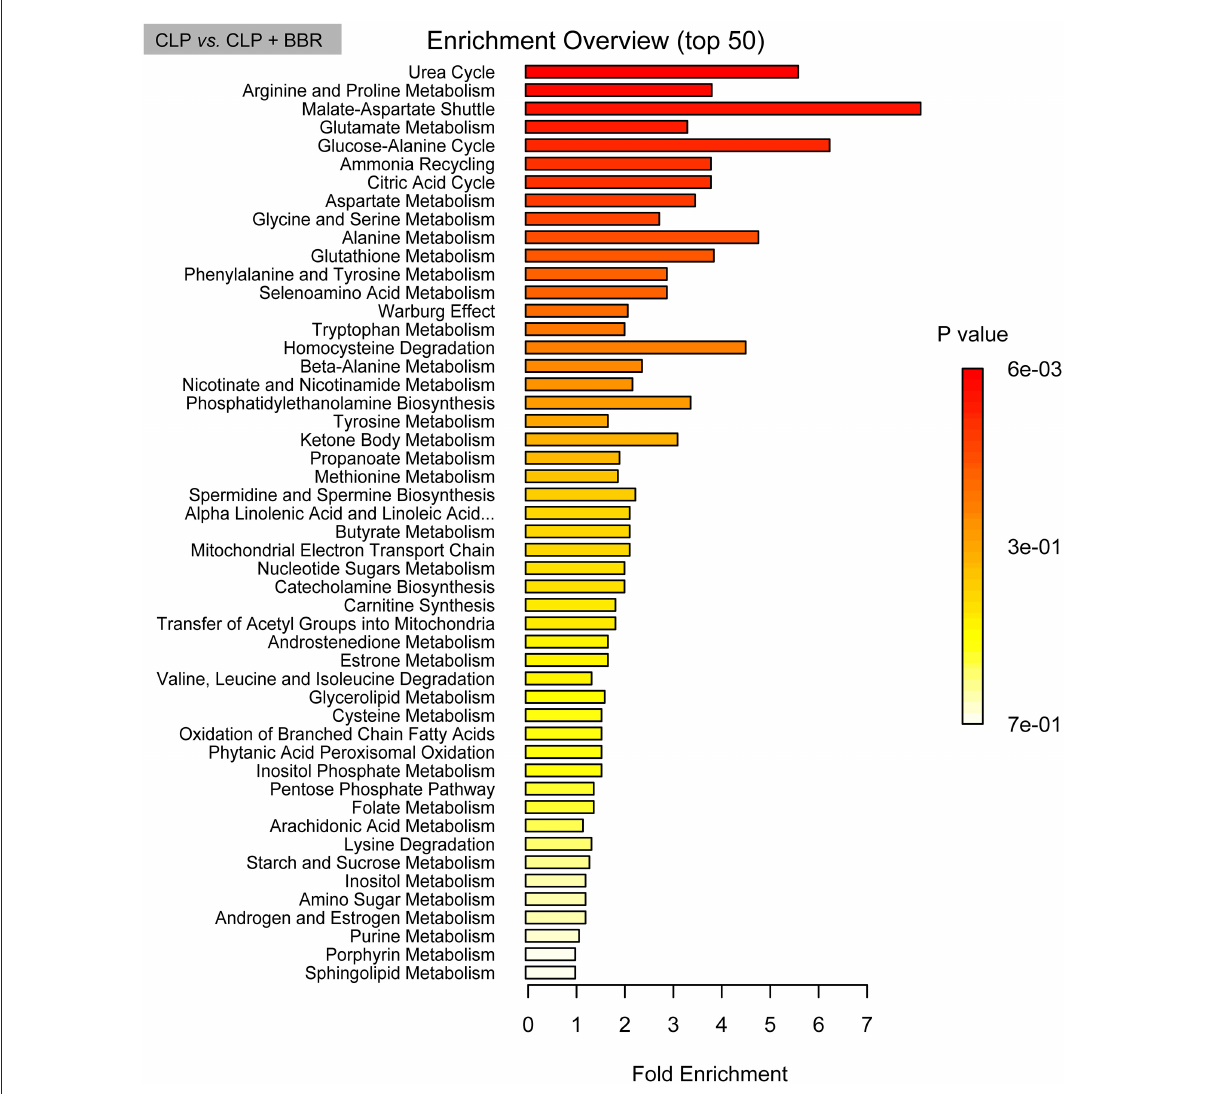
FIGURE7 The bar chart of pathway enrichment analysis based on pathway-associated metabolite sets database. The enrichment analysis was based on the metabolites with significant differences between the CLP and CLP + BBR group and analyzed by t -test ( p -value < 0.05). CLP, cecal ligature and puncture; BBR,